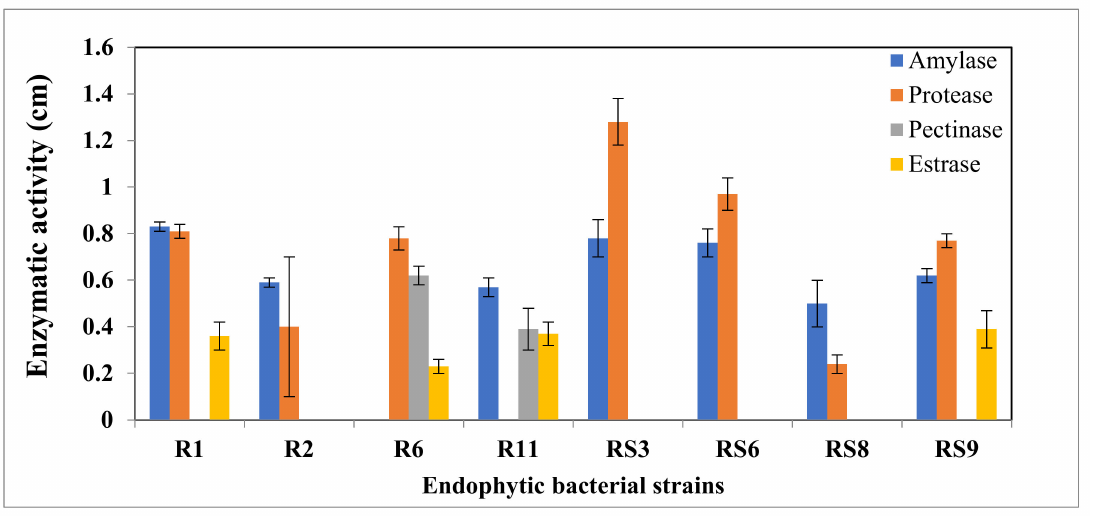
Figure 4. Enzymatic activity of endophytic bacterial strains, enzymatic Index represent the halo diameter of degradation/diameter.